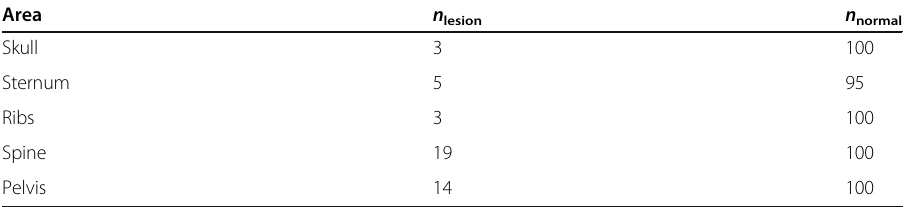
Table 4 Number of lesions ( n lesion ) and normal uptake samples ( n normal ) for the clinical patient